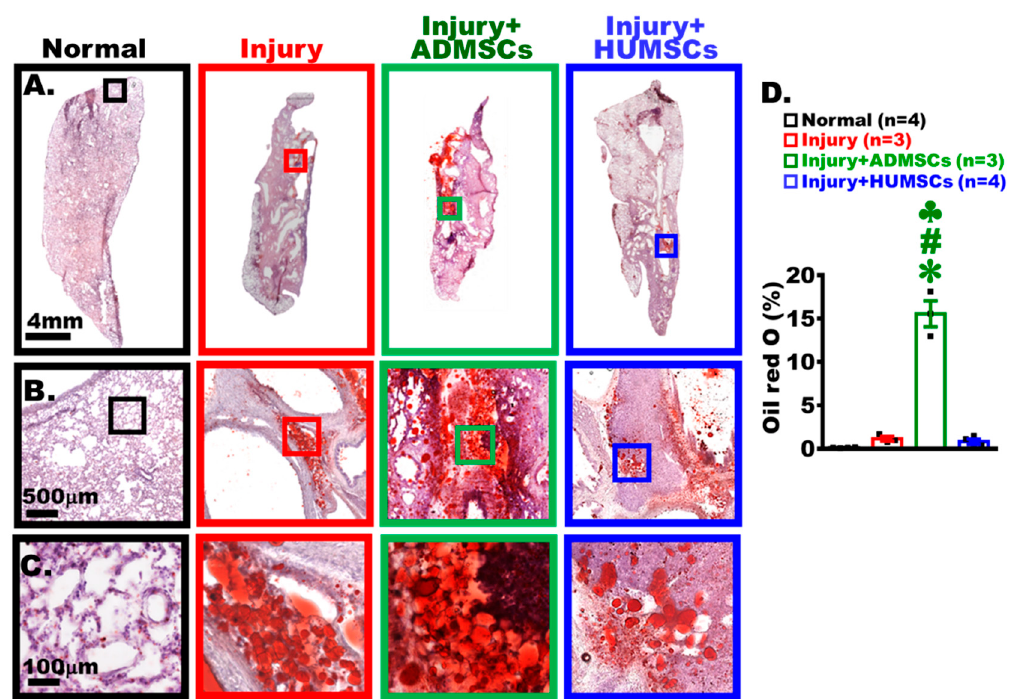
Figure 2. Transplantation of HUMSCs, but not ADMSCs, increased the alveolar volume in PF rats. The horizontal level of the trachea carina is shown in the MRI of the rat thoracic cavity. L stands for the left lung, R for the right lung ( A ). The carina was established as a reference point for image placement. In addition to the carina-containing slice, four images were acquired below the carina. To calculate the left-lung alveolar volume for each rat, the fi ve pictures were added together and the black alveolar space was quanti fi ed. The black alveolar space in these fi ve images was quanti fi ed to represent the left-lung alveolar volume of each rat. The fi ndings indicated that the alveolar volume drastically decreased following BLM damage. The alveolar volume was signi fi cantly increased by HUMSCs transplantation ( B ). Weekly weighing showed that HUMSCs transplantation im- proved the body weight of rats with PF ( C ). The fi gure shows the number of rat samples in each group ( D ). ✽ : p < 0.05 (vs. the Normal group); #: p < 0.05 (vs. the Injury group); ♣ : p < 0.05 (the Injury+ADMSCs group vs. the Injury+HUMSCs group).